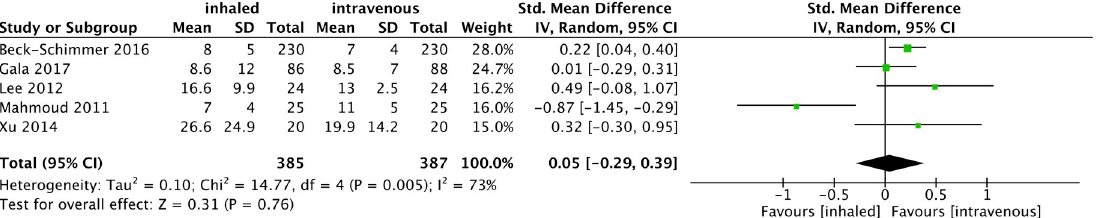
Fig 6. Forest plot for the length of hospital stay between inhaled and propofol